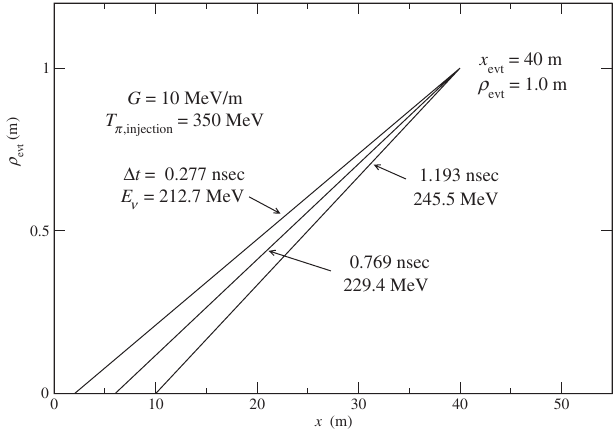
FIG. 4. Relation between the reacting neutrino’s energy, E and the time difference between the time of bunch injection and the scattering event time in the detector for a particular event ffiffiffiffiffiffiffiffiffiffiffiffiffiffiffiffiffiffi position, here at 40 m from the start of the pion accelerator and at an off-axis distance of 1 m. It shows the differences in E time difference (cid:2) t for three different pion decay positions. The kinetic energy of pions at injection has been taken to be 350 MeV and the accelerating gradient is 10 MeV = m . (We have assumed here the higher neutrino energy at this laboratory angle.) Thus, in this example, if the absolute time of this scattering event can be determined relative to the injection time with an accuracy of better than (cid:7) 500 ps , then the energy of the incident neutrino that initiated the event will be deter- mined to an accuracy of better than (cid:7) 15 MeV